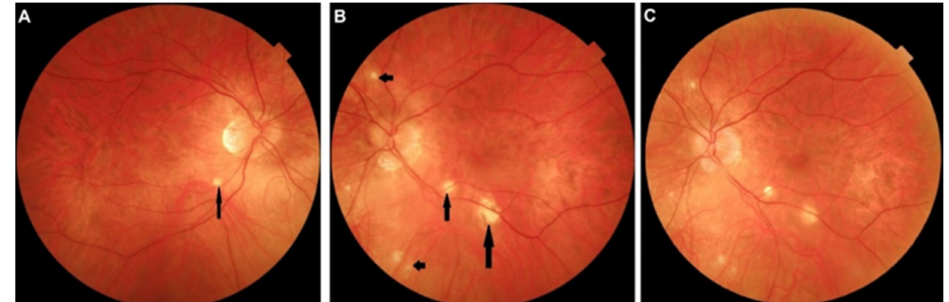
Figure 15. Idiopathic multifocal choroiditis. ( A , B ) Fundus aspect in last control, after 11 years of follow up. Scar lesions are outside the arcades of posterior pole (arrows). In ( C ), the fundus of the left eye 3 years before. Comparing ( B ) with ( C ), there are no additional scars for the last 3 years under systemic